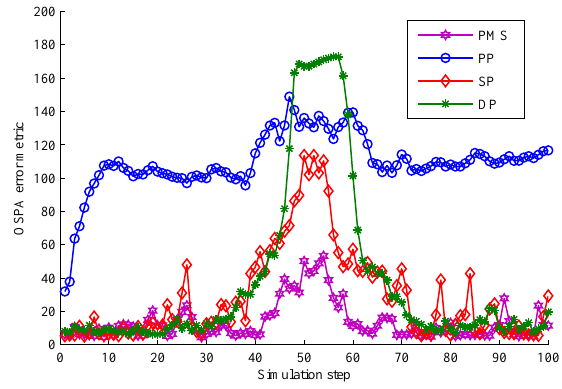
Figure 15. The comparison of four approaches in OSPA distance.